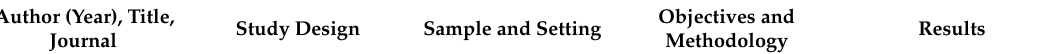
Table 2. Effects of vitamin D